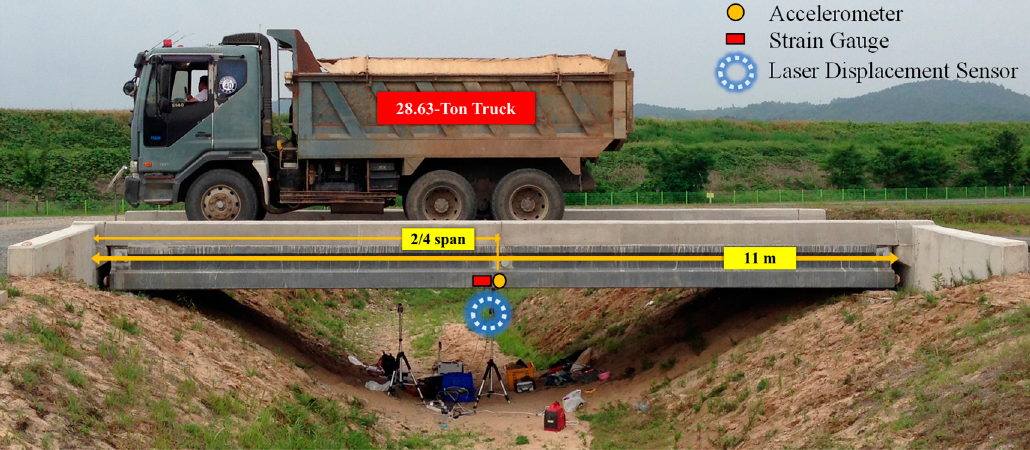
Figure 7. Experimental setup for field validation.